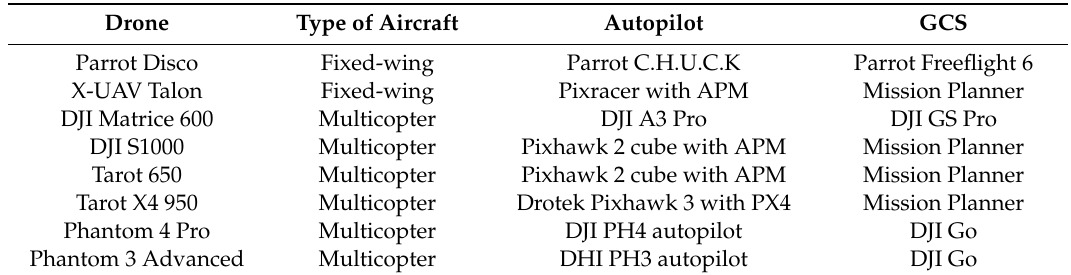
Table 1. Drones, autopilots and GCS software used during the flights.